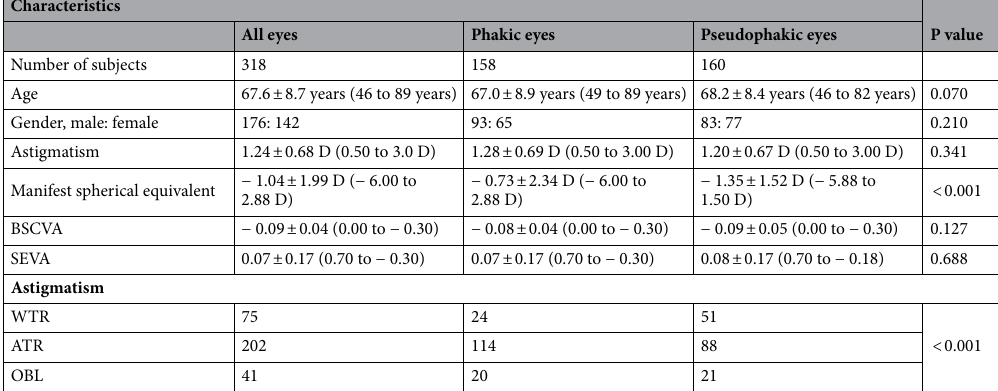
Table 1. Demographics of the study population. D = diopter, BSCVA = best spectacle-corrected visual acuity, SEVA = spherical equivalent visual acuity, WTR = with-the-rule, ATR = against-the-rule, OBL = oblique astigmatism.